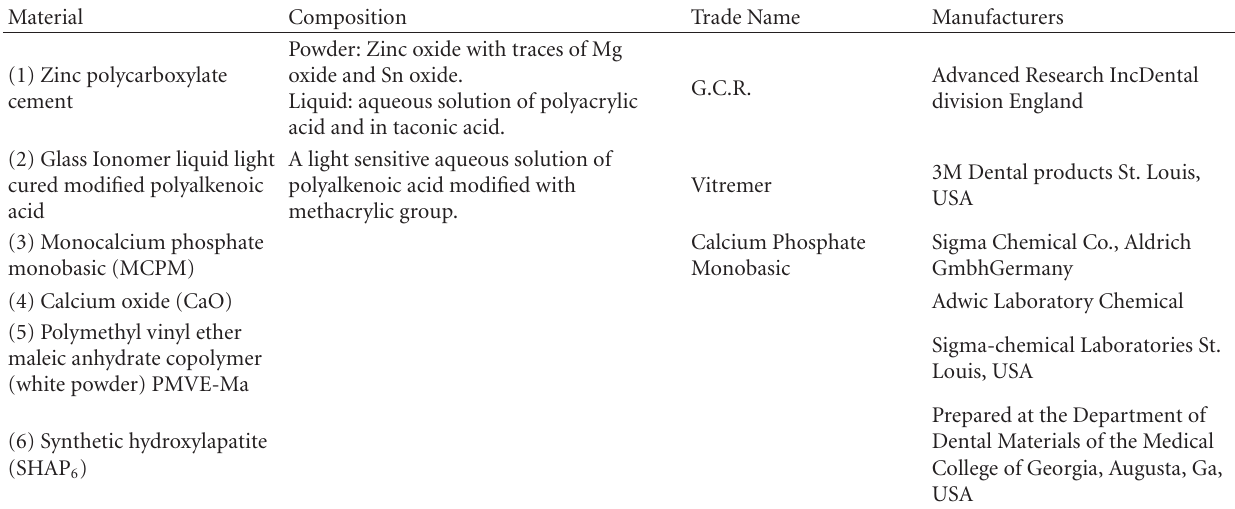
Table 1: Materials used in this study and their